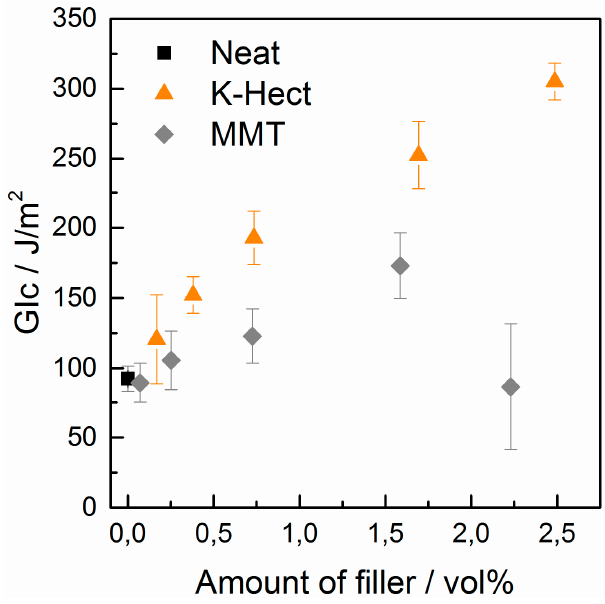
Figure 5. Energy release rate of diglycidyl ether of bisphenol A (DGEBA) nanocomposites with different amounts of montmorillonite (MMT) or K-Hect.